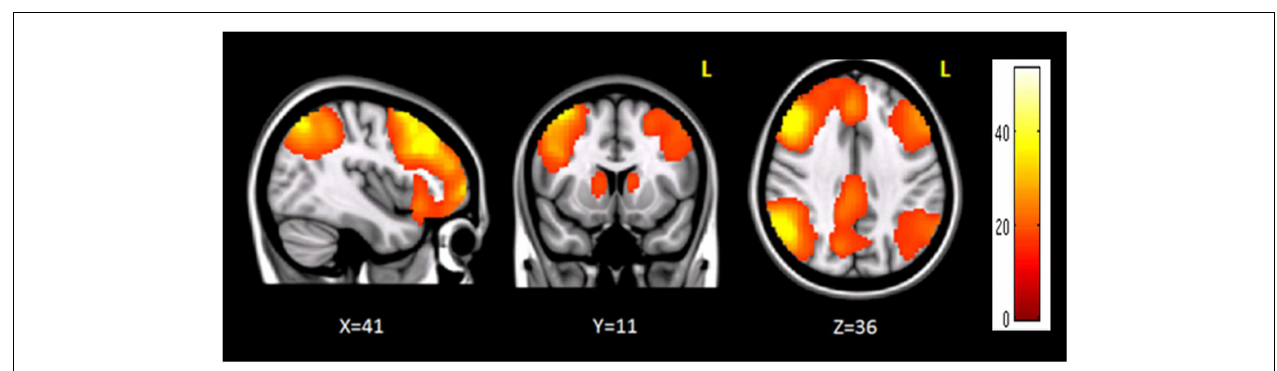
FIGURE 2 | Brain regions functionally correlated to the right prefrontal cortex used as seed in seed-based analysis .The color bar represents the t -scores.